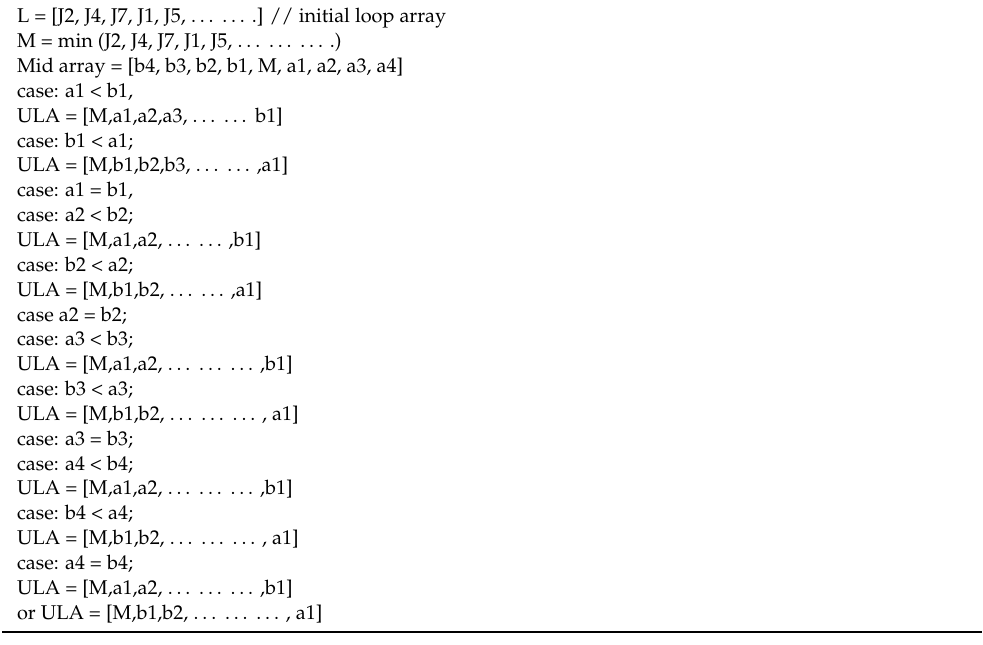
Algorithm 1 . Code structure for determining the unified loop array, ULA, for single master joints.